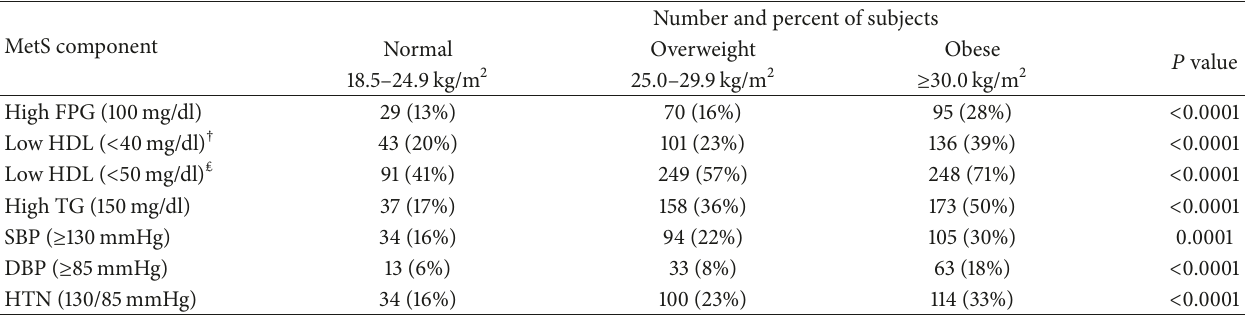
Table 4: Number of subjects and prevalence of Metabolic Syndrome components in Central and South Americans by BMI category. Number and percent of subjects MetS component Normal